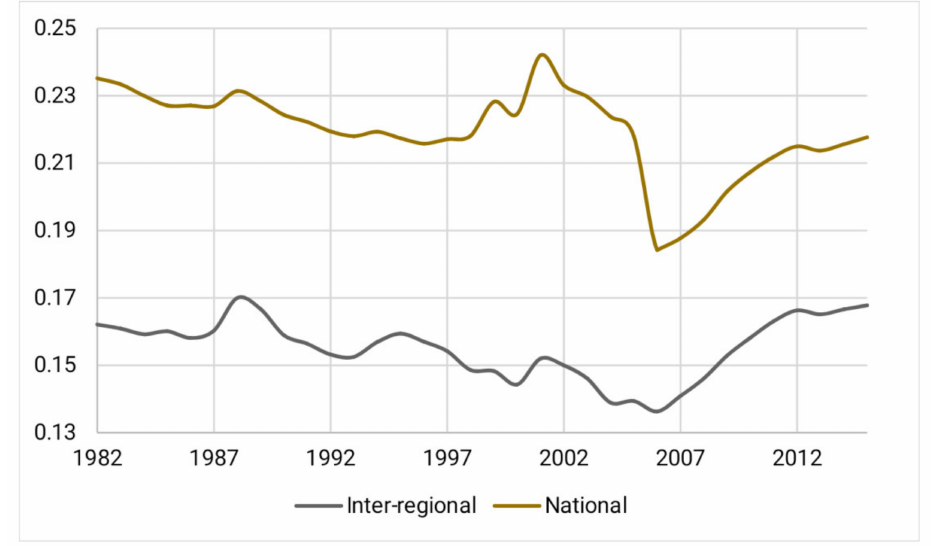
Figure 5. Gini coefficients of China’s transport